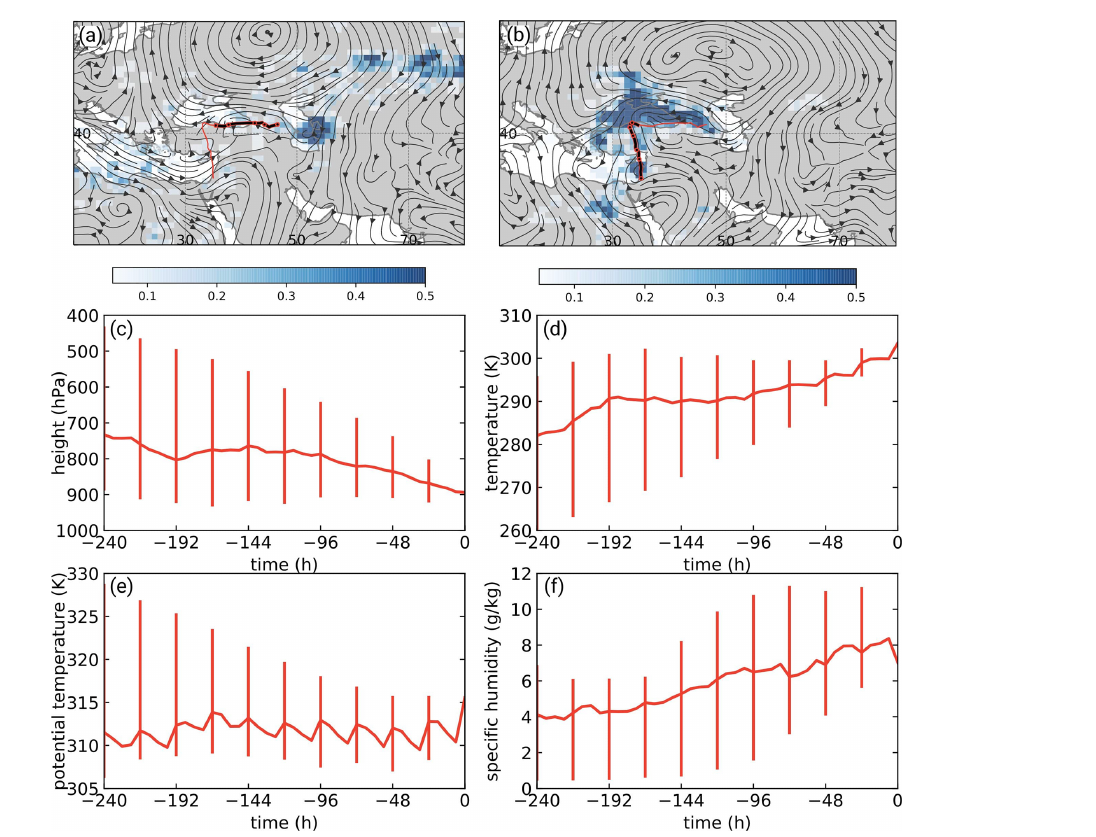
Figure 7. Backward trajectory air parcel tracking for the mid-August 2010 heat wave initialized on 15 August 2010 at 12:00UTC with (a) circles indicating days (from − 10 to − 6d before 15 August 2010 at 12:00UTC), gray shading indicating trajectory density 10d before onset (number of trajectories per 1000km 2 ) and streamlines of 800hPa wind (averaged between − 10 and − 6d before 15 August 2010 at 12:00UTC). Panel (b) is the same as panel (a) but for − 5 to − 1d and a trajectory density of 5d before onset. The median evolution of (c) height (hPa), (d) temperature (K), (e) potential temperature (K) and (f) specific humidity (gkg − 1 ) of the tracked air parcels is also shown. The interquartile range is plotted for the physical properties of the air parcels. A value of 0h corresponds to 15 August 2010 at